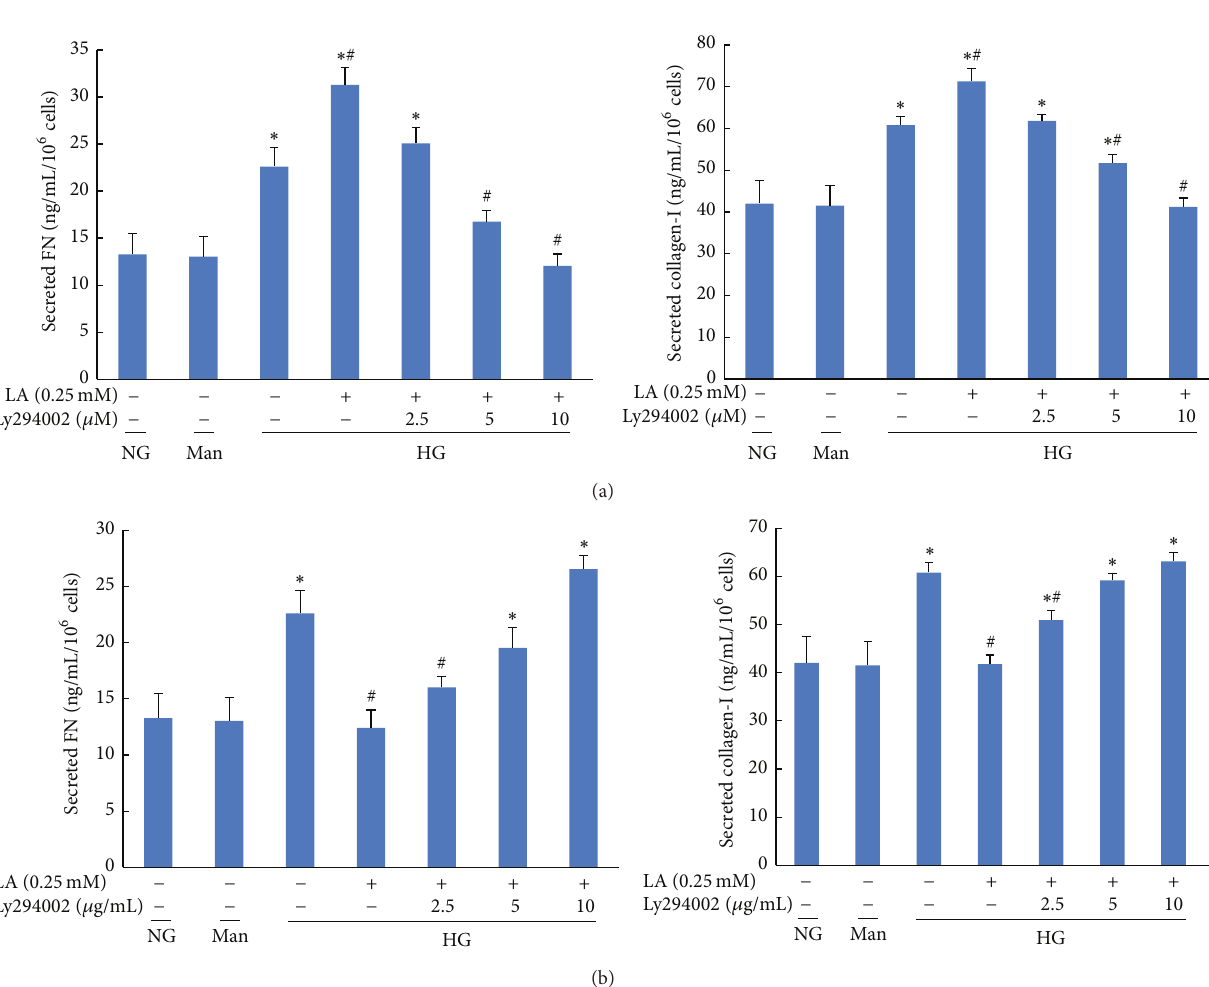
Figure 8: LY294002 prevented the secretions of FN and collagen-I induced by 0.25 mM LA in high glucose-cultured MCs. STO-609 reversed the inhibition of FN and collagen-I secretions induced by 1.0mM LA in high glucose-treated MCs. (a) Representative of the effects of LY294002 on 0.25 mM LA induced FN and collagen secretion in supernatants. (b) Representative of the effects of STO-609 on 1.0mM LA induced FN and collagen secretion in supernatants. Values are given as mean ± SD from 3 independent experiments in quadruplicate and 𝑃 < 0.05 is considered statistically significant. Note: ∗ 𝑃 < 0.05 versus NG; # 𝑃 < 0.05 versus HG. Abbreviations: NG, normal glucose (5 mM); Man (5 mM glucose + 25 mM mannitol); HG, high glucose